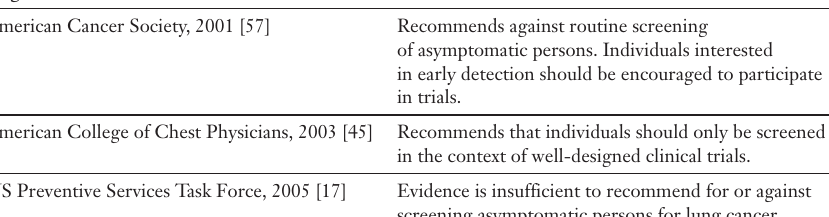
Selected recommen- dations from health